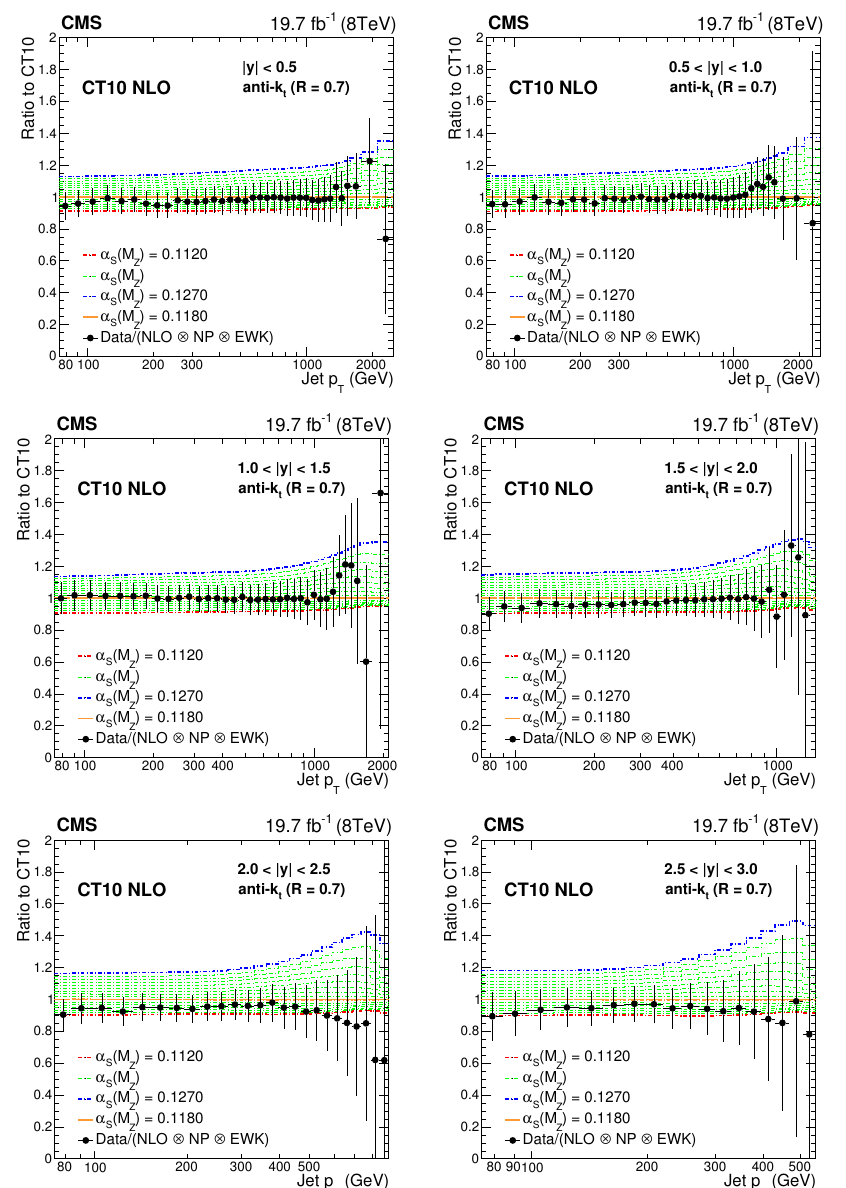
Figure 11 . Ratio of data over theory prediction (closed circles) using the CT10 NLO PDF set, with the default (cid:11) S ( M Z ) value of 0.118. Dashed lines represent the ratios of the predictions obtained with the CT10 PDF set evaluated with di(cid:11)erent (cid:11) S ( M Z ) values, to the central one. The error bars correspond to the total uncertainty of the